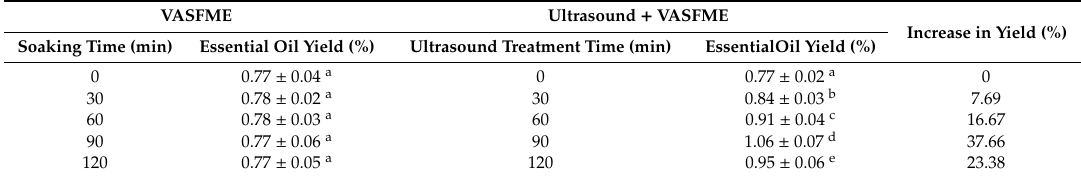
Increase in Yield (%)